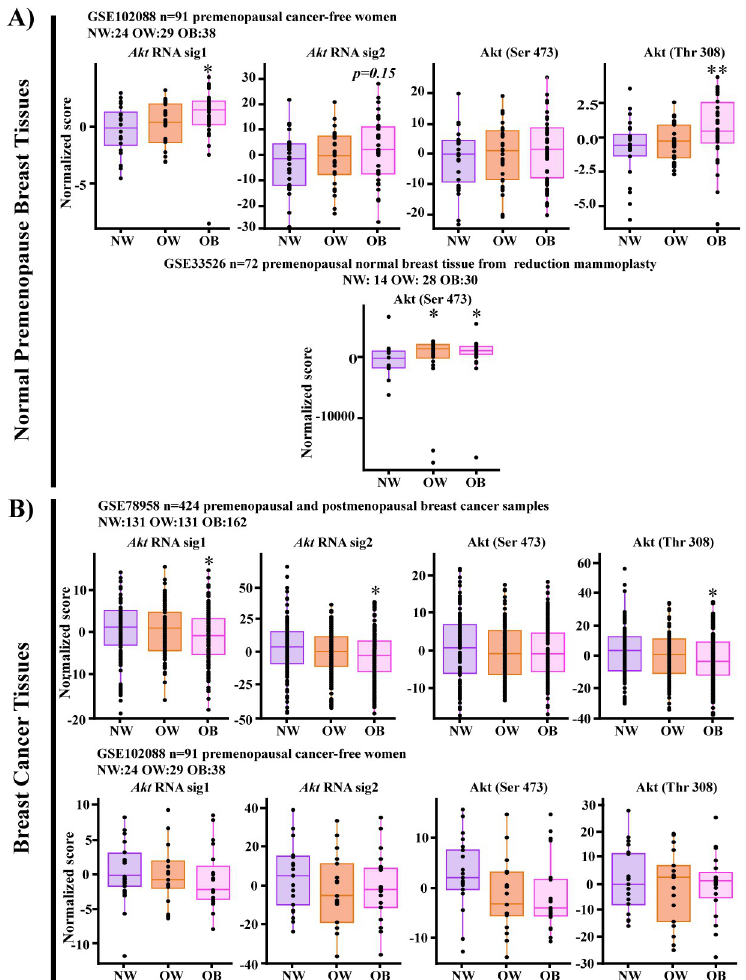
Fig 1. Akt phosphorylation landscape evaluated through gene expression signatures in non-tumoral or tumor breast tissues of women with different BMI. Bioinformatic analysis of the mRNA gene expression signatures that mirrored the phosphorylation of Akt in Ser 473 and Thr 308 in public datasets recovered from the GEO database in breast tissue of normal-weight (NW), overweight (OW) and obese (OB) women. A) RNA gene signature scores describing Akt activation (Akt sig 1 –in-house signature- and sig 2) or Akt phosphorylation in non-tumoral breast tissue from premenopausal women. B) RNA gene signature scores describing Akt activation (Akt sig 1–in-house signature- and sig 2) or Akt phosphorylation in tumors of pre and postmenopausal women (upper panel) or breast tumors from premenopausal women (lower panel). � < 0.05 �� < 0.005 comparisons between groups.